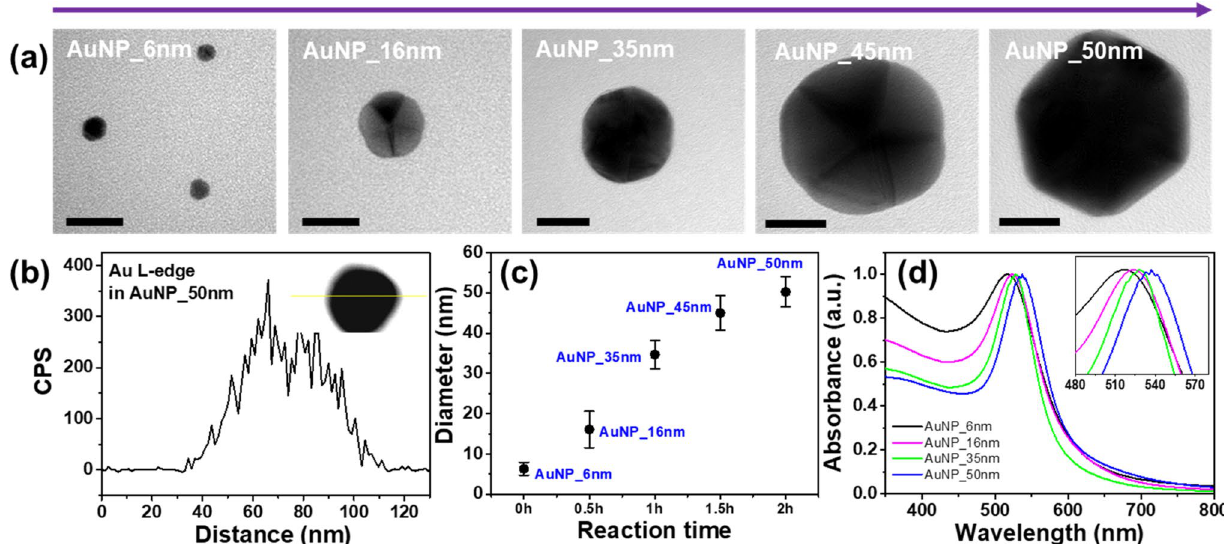
Figure 2. Morphological, chemical, and optical characteristics of the AuNPs. ( a ) TEM images of AuNPs according to reaction time. The scale bar is 20 nm. ( b ) EDS line-scan analysis of Au L-edge distribution across the AuNP_50nm. ( c ) Size distribution of the AuNPs as a function of reaction time. ( d ) UV–Vis absorption spectra of the AuNPs. The inset indicates a magnified view near the absorption peaks.